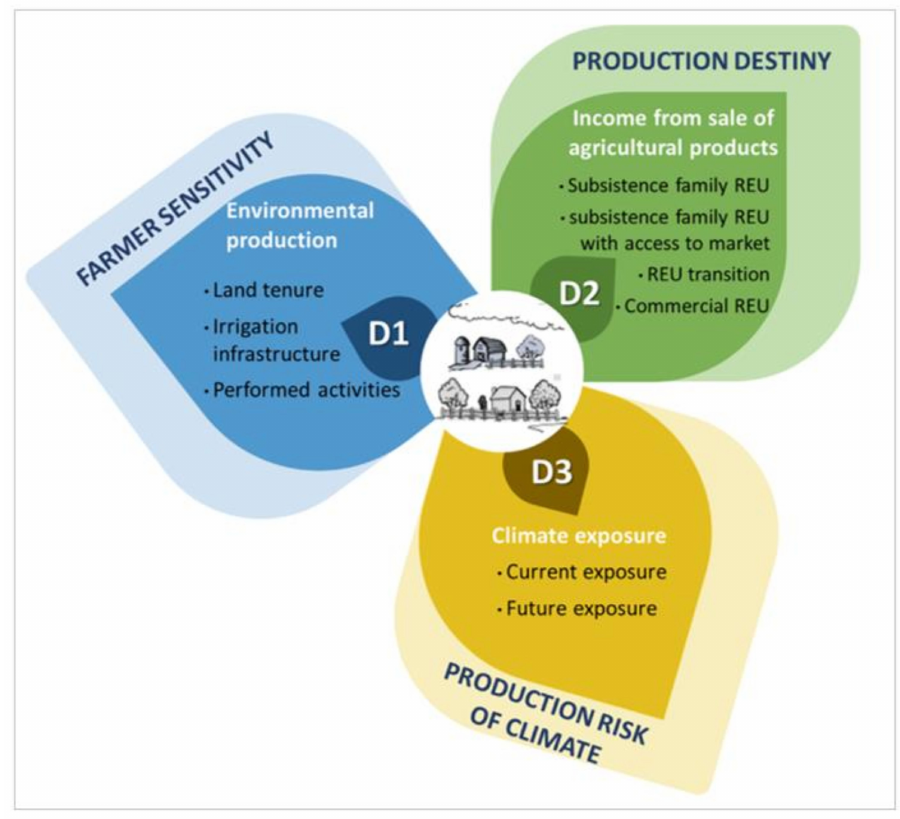
Figure 1. Dimensions included in the Multidimensional typology of Mexican